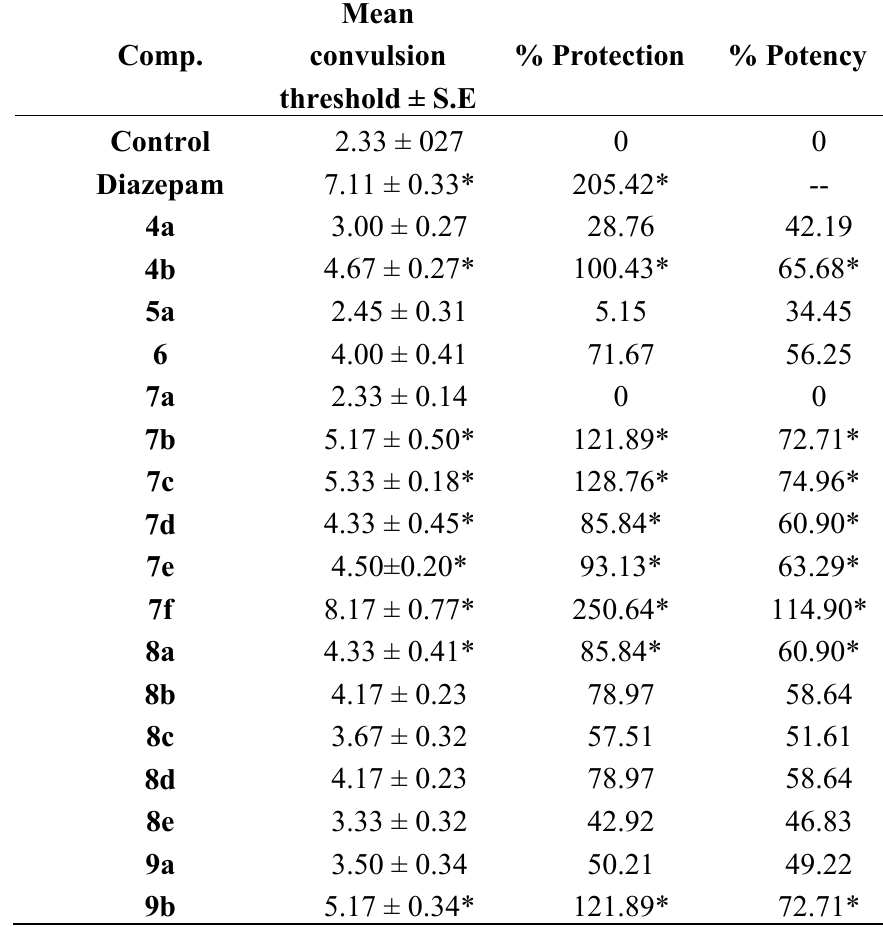
Table 1. Anticonvulsant activity of diazepam and the newly synthesized compounds.